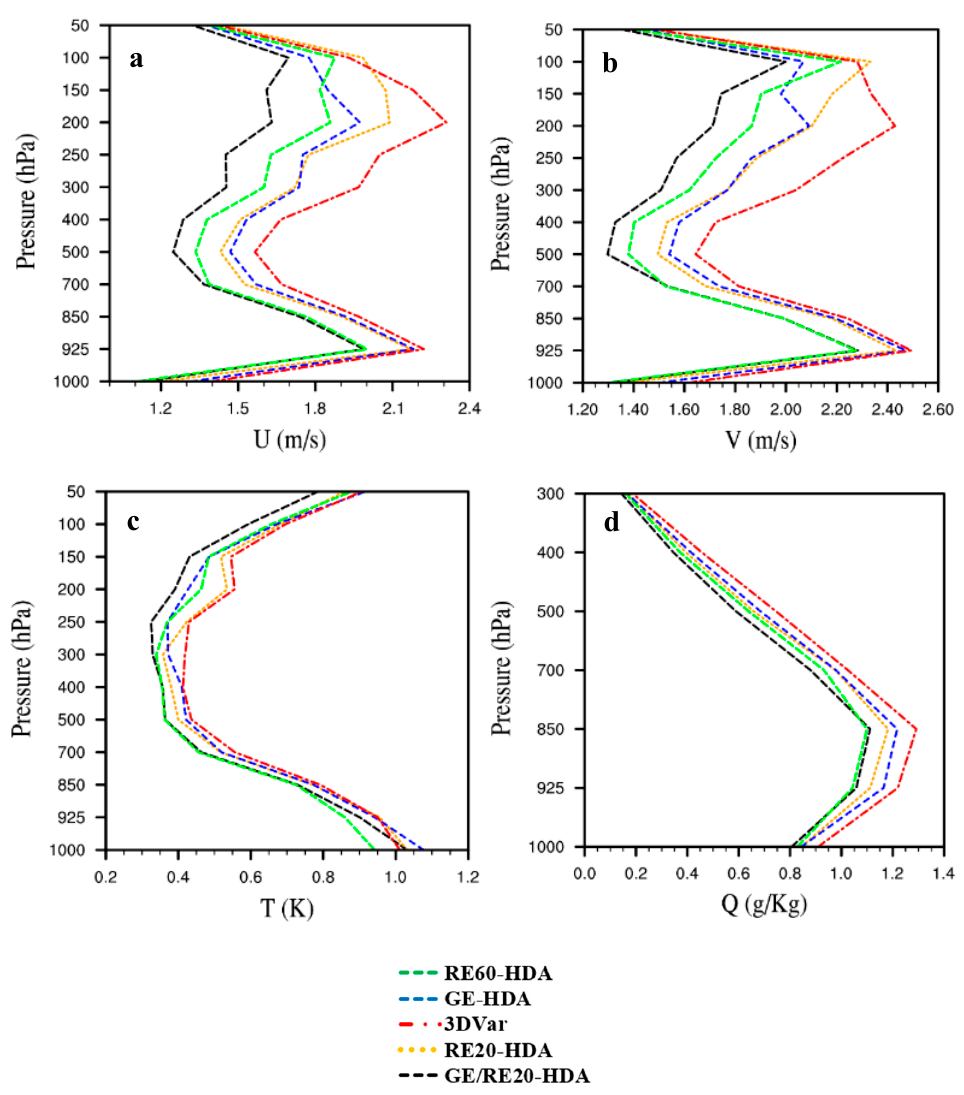
Figure 6. The vertical profiles of the average analysis root mean squared error (RMSE) against the European Centre for Medium-Range Weather Forecasts (ECMWF) analysis. ( a . Zonal wind (m/s); b . Meridional wind (m/s); c . Temperature (K); d . Water vapor mixing ratio (g/kg).)